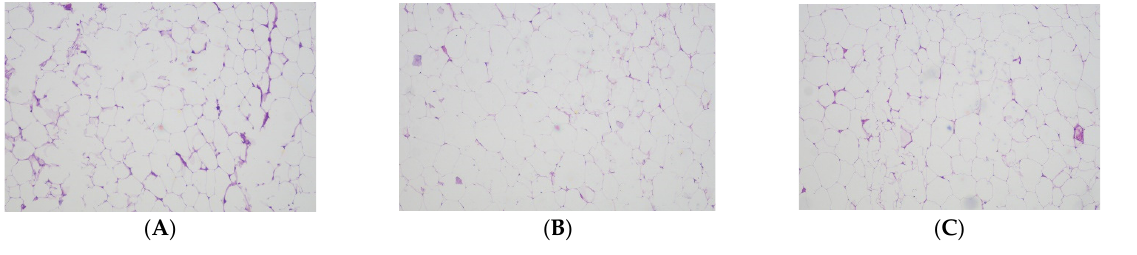
Figure 1. Representative photomicrographs of epididymal adipose tissue stained with hematoxylin- eosin. ( A ) CO group; ( B ) OB; ( C ) OBSe. All images are shown at ×100 magnification. Adipocyte sizes were larger ( p = 0.0072) in OB group compared to CO group, while no differences ( p > 0.05) were observed between OB and OBSe groups, according to chi-square test and Student’s t -test.